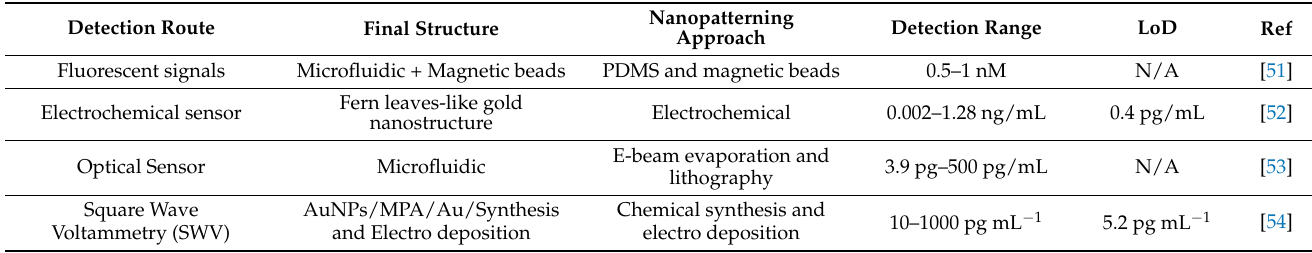
Table 1. Performance and features comparison: previously published A β (1–42) sensor versus the proposed ORC modified Au